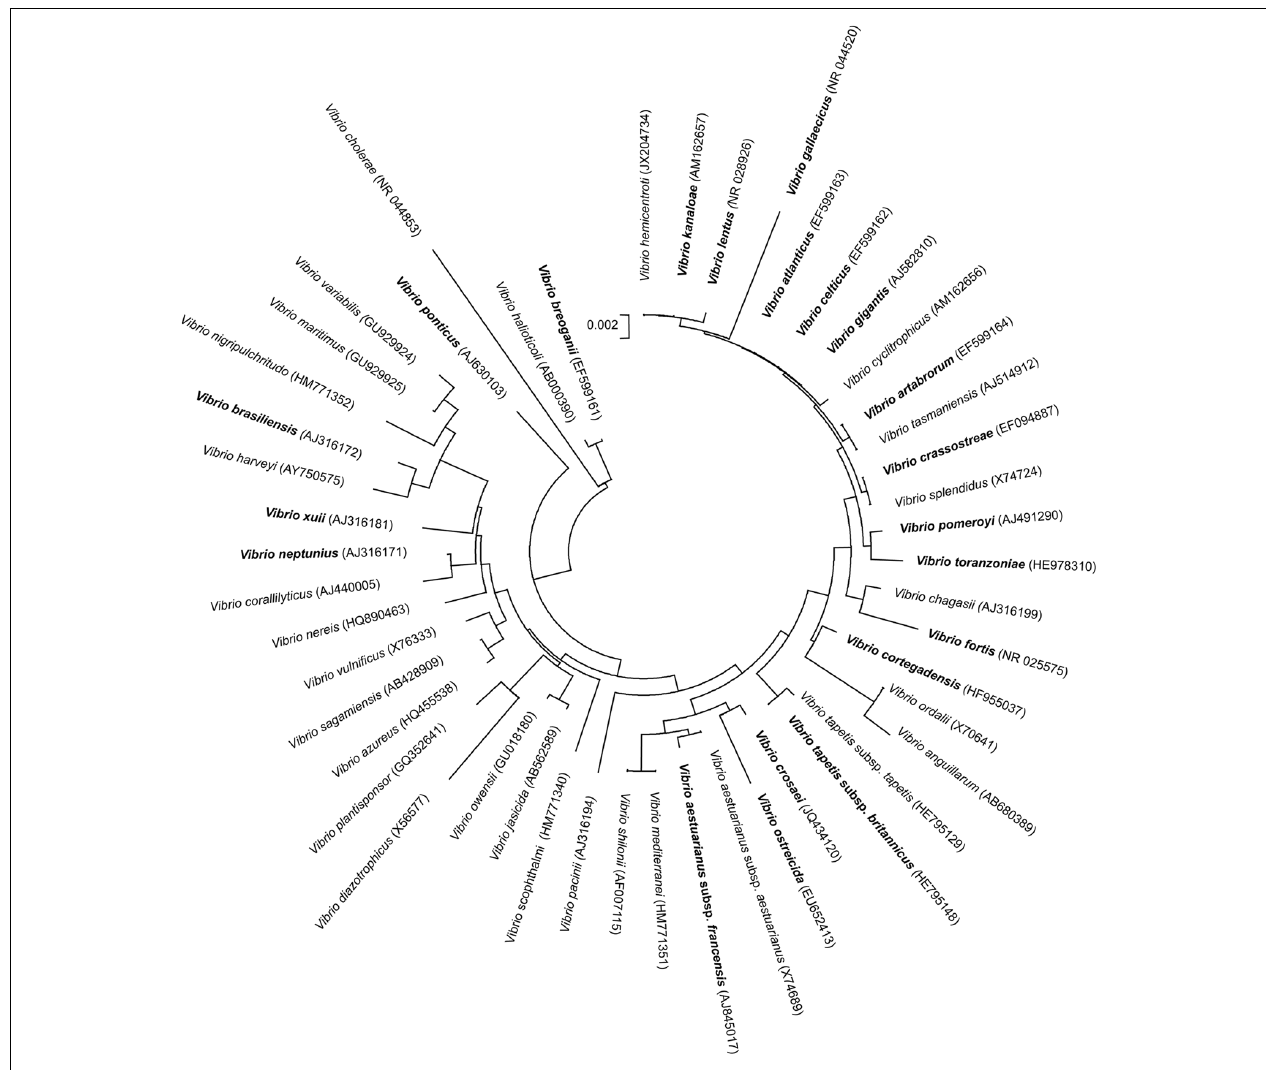
FIGURE 1 | Phylogenetic tree based on partial 16S rRNA gene sequences obtained by the neighbor joining method, including the Vibrio species associated with molluscs together with other representative species of the genus. In bold are represented 19 new